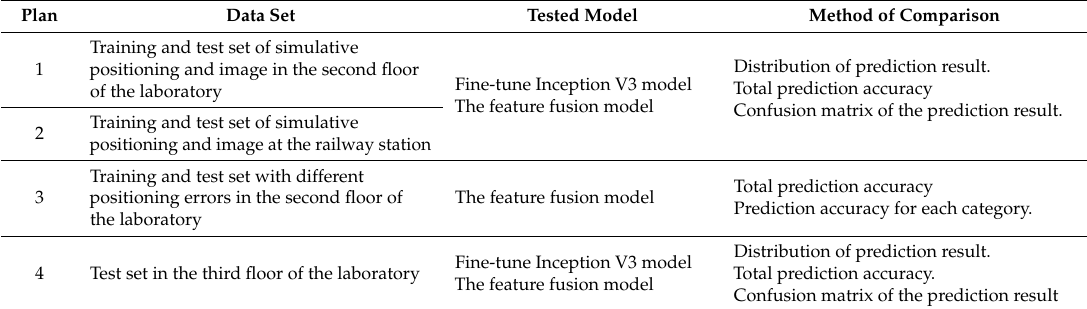
Table 2. Design of different experimental